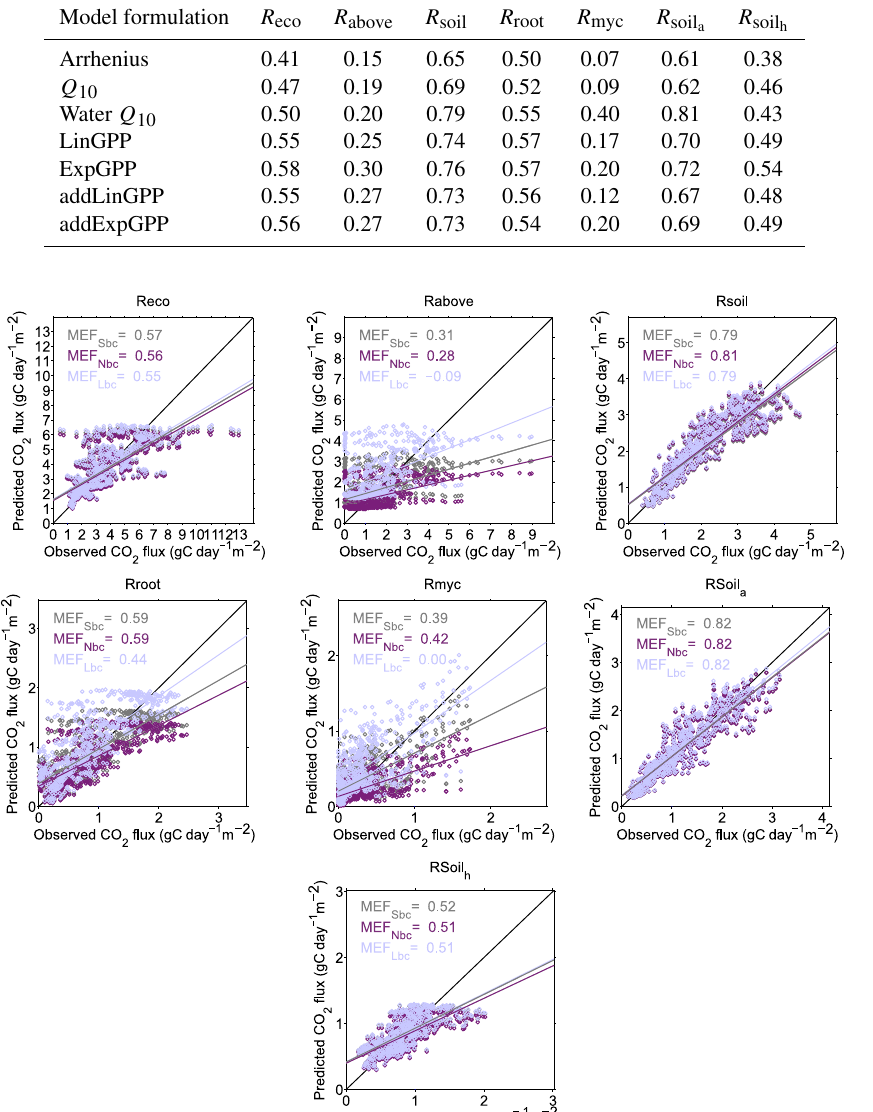
Figure 9. Observed and predicted outgoing CO 2 fluxes; 613 time steps of daily averaged CO 2 effluxes for 2 years at the Alice Holt oak forest site. The predicted values are generated with the models automatically built by the GEP approach with the settings given in Table 1 for the following types of respiration, R eco , R above , R soil , R root , R myc , R soil b ias c orrection terms: s mear term, n aive, and l og-normal term. The figure contains the MEF values for each type of bias correction in each respective